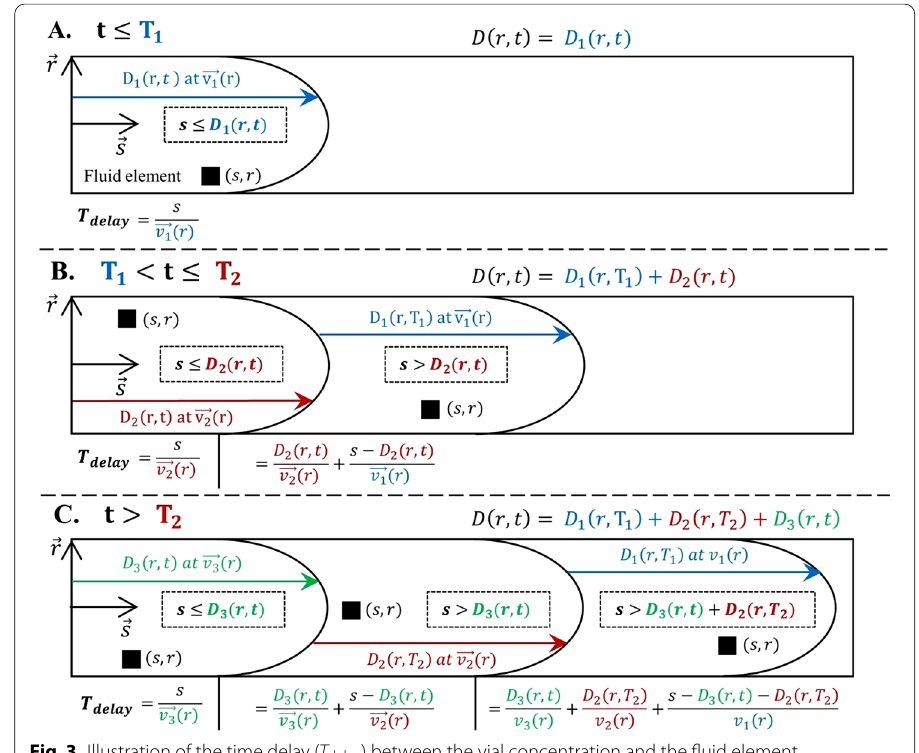
−→ v r ) . T 1 ( delay is thus expressed as the ratio −→ v s r )( T ) . B For T 1 < t ≤ T 2 , −→ v 1 ( delay = 1 ( r ) −→ v s r )( T ) . Case 2. s > D 2 ( r , t ) , the fluid −→ v 2 ( delay = −→ v 2 ( r ) r ) and the distance s − D r , t ) at the velocity 2 ( 2 (